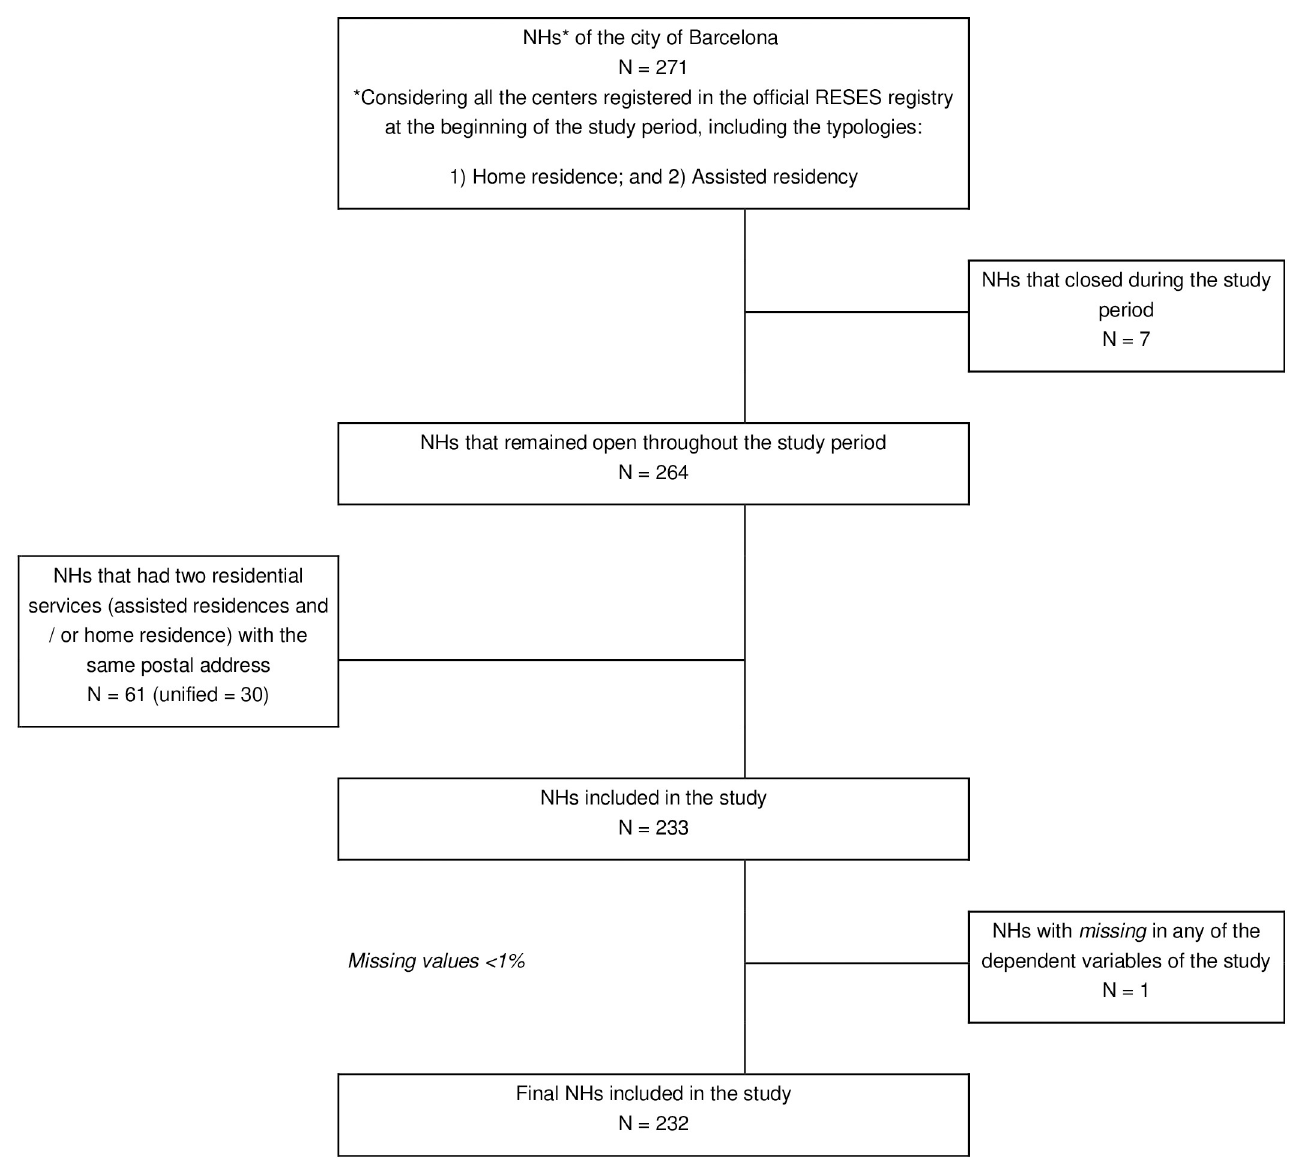
Fig 1. Flow diagram of the selection of the study